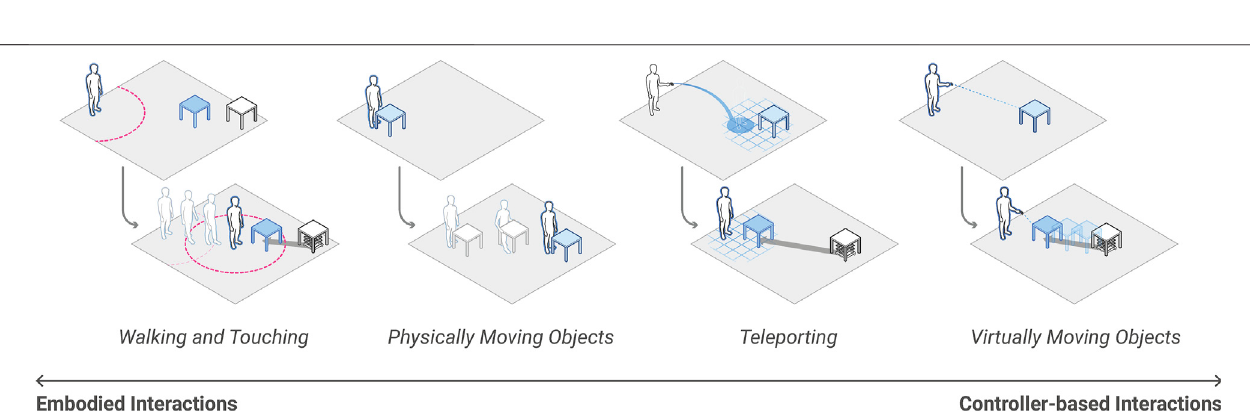
FIGURE9 | RoomShift can provide encountered-type haptics for users in avariety ofVR interactions, including when users walkto touch objects,physically move virtual objects, virtually teleport to new locations, and virtually move objects.